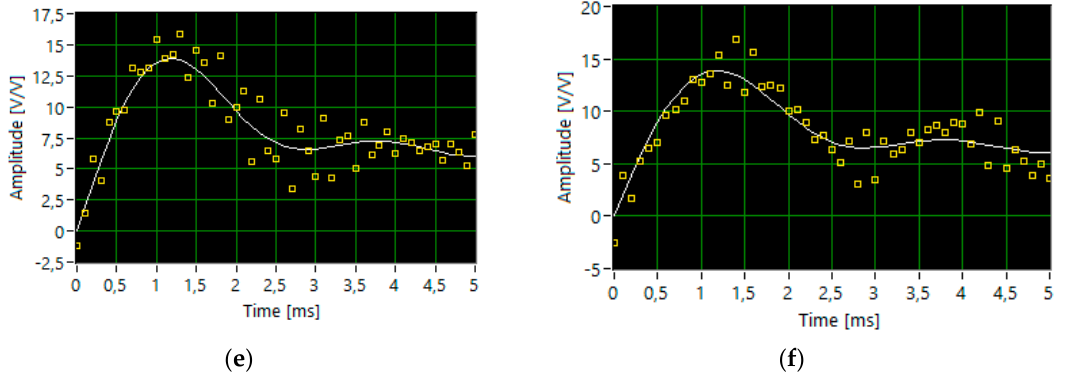
Figure 5. The segments of time waveforms of the original (white line) and reconstructed signal (dotted yellow line) for following parameters: p , accuracy and the number of iterations, respectively: ( a ) 0.01, 99.67%, 308; ( b ) 0.1; 99.56%, 330; ( c ) 0.3, 99.76%, 490; ( d ) 0.5, 99.99%, 690; ( e ) 0.8, 99.9%, 406; ( f ) 0.9, 99.39%, 384.